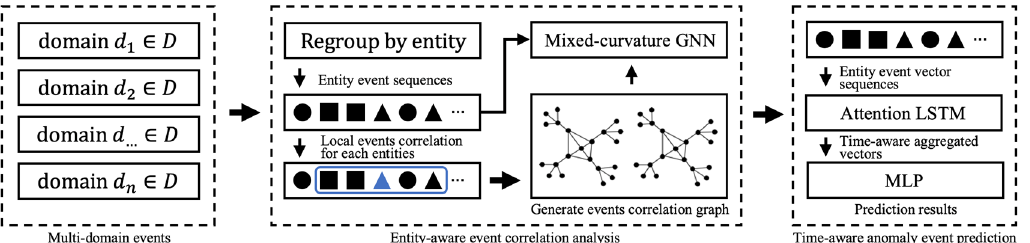
Figure 1. The overall architecture of CDSTAEP: In CDSTAEP, we first divide the complex network data from different domains D, using the target host as the anchor point to separate the behavior sequence, form a correlation sequence of local events through behavior, and construct an event as- sociation graph 𝐺 (cid:3032)(cid:3049)(cid:3032)(cid:3041)(cid:3047)(cid:3046) (cid:3030)(cid:3042)(cid:3045)(cid:3045)(cid:3032)(cid:3039)(cid:3028)(cid:3047)(cid:3036)(cid:3042)(cid:3041) based on the entity local event sequence. The blue square shows the intermediate sampling process of building a cross-domain event association graph , see Section 4.1.2 for details. Particularly, we feed the event correlation sequence and the constructed event as- sociation graph into the mixed-curvature GNN, and perform representation learning on the graph in the Riemannian space M, and the intermediate result of this step is output as a sequence of entity event vectors. At the same time, the entity event vector sequence is sent to the attention-based LSTM to obtain the relationship weight between events, and the final abnormal event prediction probabil- ity distribution is obtained through multi-layer perceptron (MLP). The final abnormal event predic- tion probability and accuracy comparison is shown in Algorithm 1.